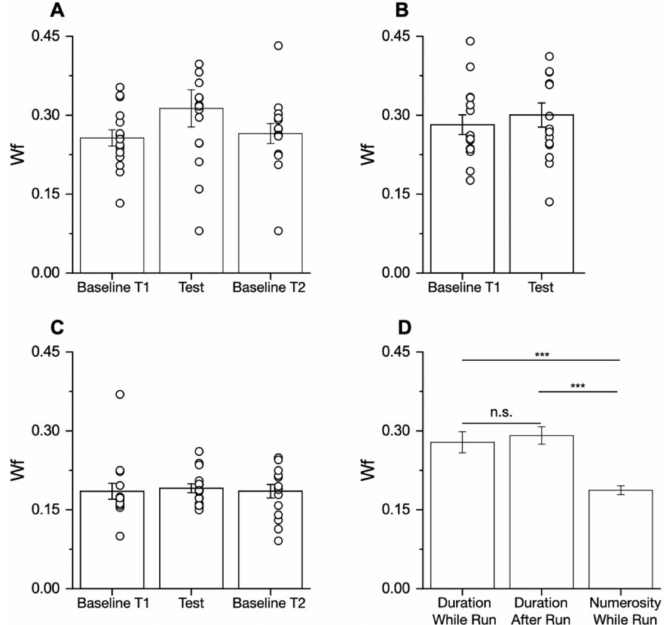
Figure 7. Perception precision. Bar plot showing estimation precision (Wfs) for duration ( A , B ) and numerosity ( C ) tasks. Bars show average, error bars are ± 1 SEM, and circles are individual data. ( D ) Average Wfs for the duration and numerosity conditions. *** p < 0.001. n.s.–nonsignificant.